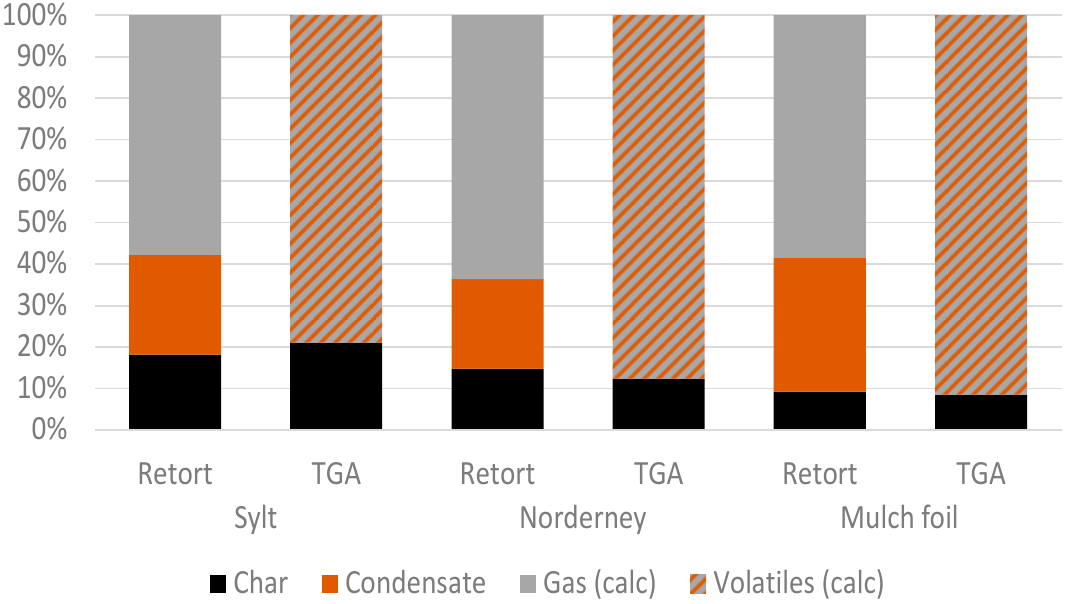
Figure 14. Comparison of product yields from pyrolysis trials in retort furnace and TGA in wt%.